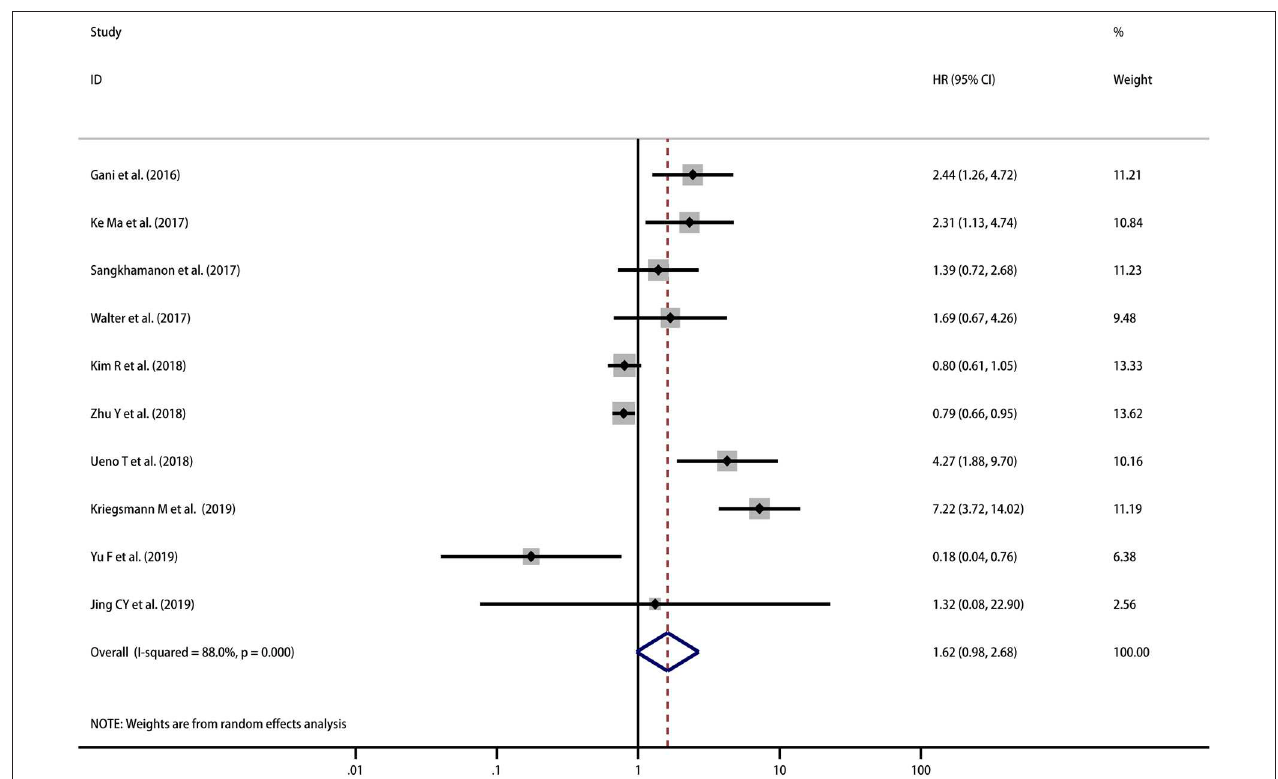
FIGURE 2 | Meta-analysis of the correlation between PD-L1 expression in TCs and OS among patients with CCA.